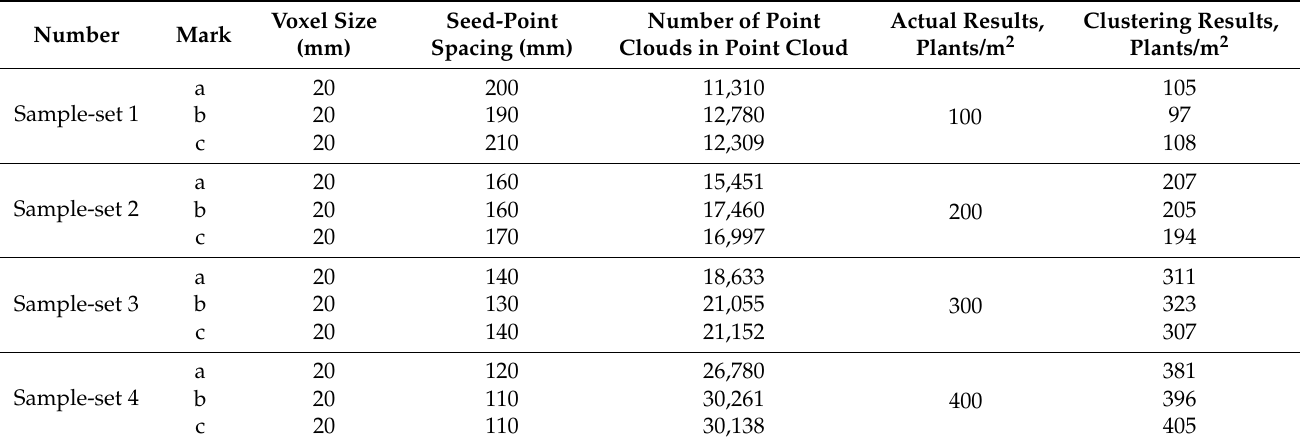
Figure 7. Supervoxel clustering result in standard experiment group. Table 3. Supervoxel clustering parameters and results of the standard experiment